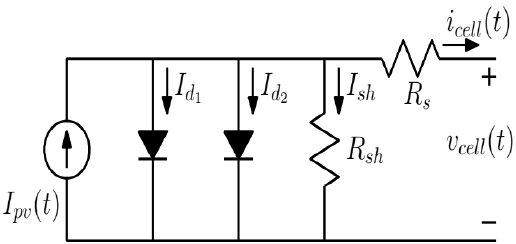
Figure 3. Photovoltaic (PV) panel double-diode model representation.